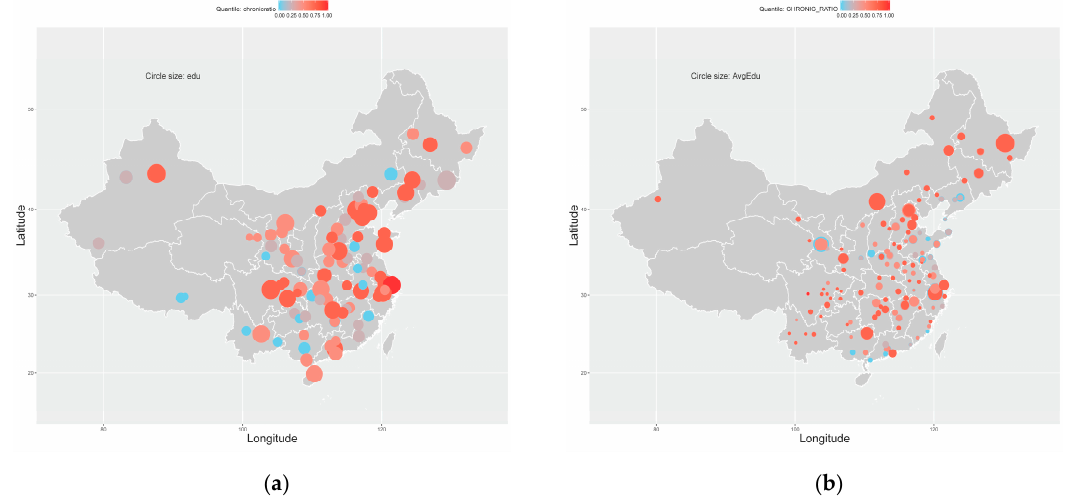
Figure 1. Geographic distributions: income and the prevalence of chronic diseases. ( a ) NHSS; ( b ) CHARLS.